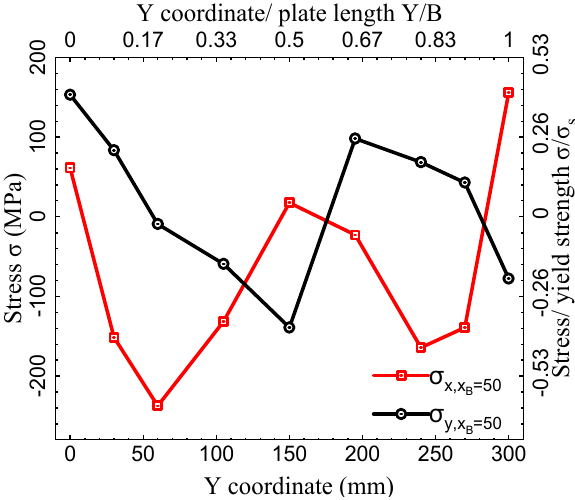
. Figure 30. The stress on path L yB = 50 (cid:3251) (cid:2880)(cid:2873)(cid:2868)